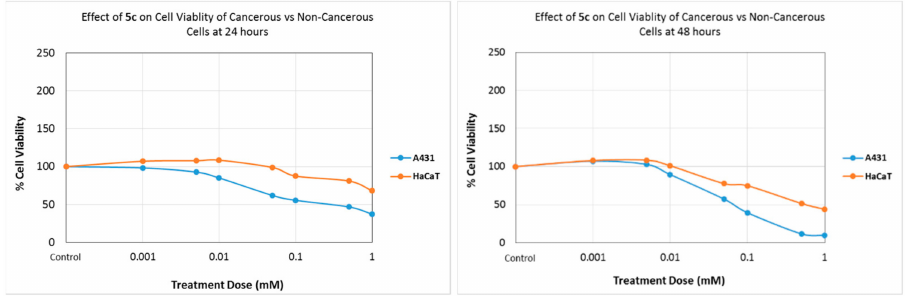
Figure 2. E ff ect of 5c on cell viability of cancerous vs. noncancerous cells at 24 h ( left ), 48 h ( right